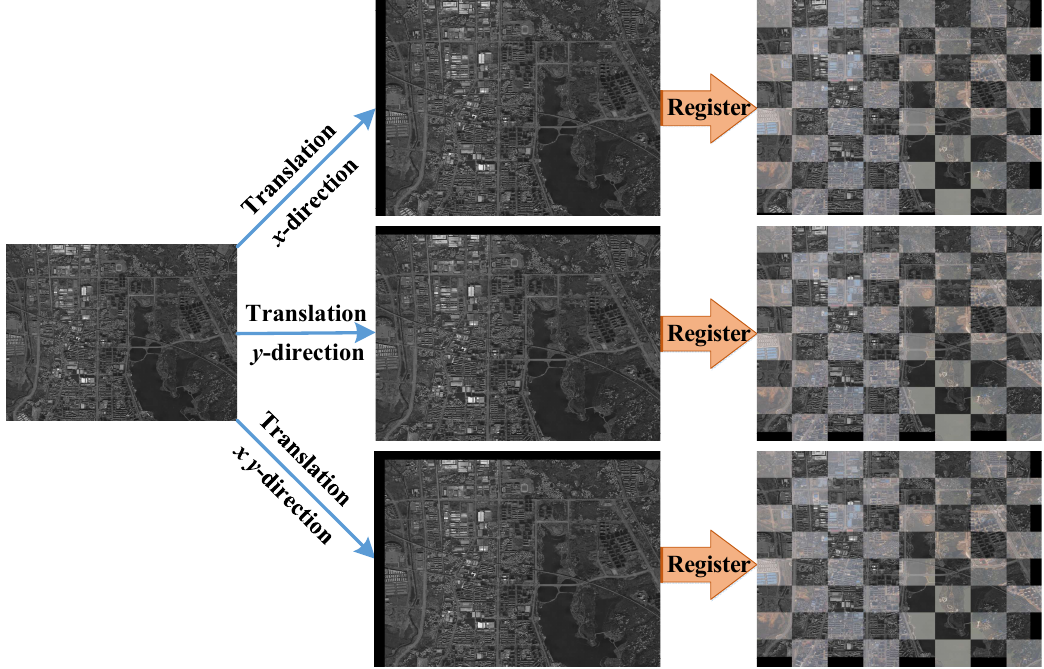
Figure 8. Mid-infrared image after translation and the registration result. The edges of the checkerboard visualization are neatly coincident. Table 4. Quantitative evaluation result of the mid-infrared image and visible orthomosaic image after translation. Bold indicates the minimum value.